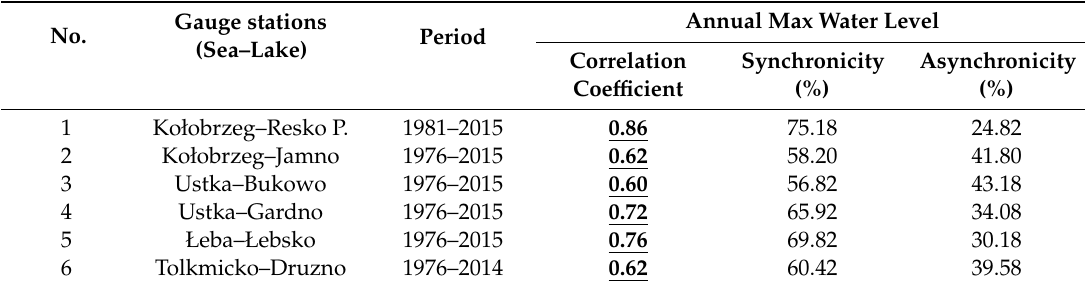
Table 5. Results of analysis of correlation and synchronicity between the Baltic Sea and the analyzed